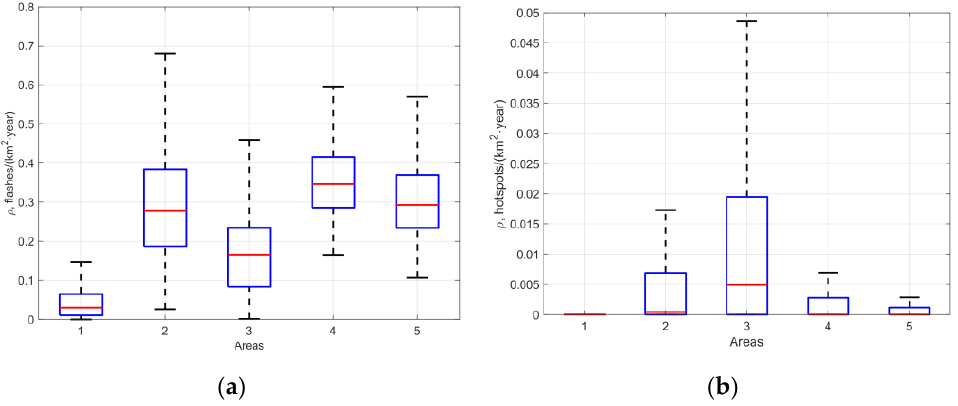
Figure 3. Statistical characteristics for natural zones in Western Siberia for the warm season from 2016 to 2021: lightning discharge density (flashes per km 2 per year) ( a ) and hotspots density (hotspots number per km 2 per year) ( b ).